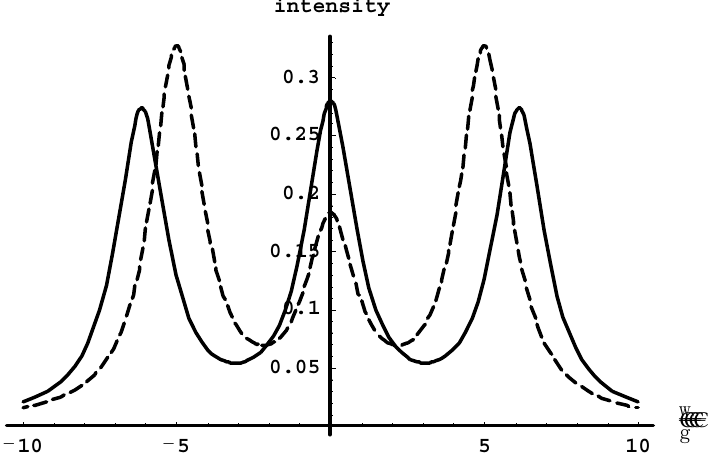
Figure 17. Comparison of the theoretical spectra of the Ly α line for the above example of tokamak T-10 with the allowance for the spiraling trajectories of the perturbing electrons (solid line) and without this allowance (dotted line). The spectra were calculated for the observation at the angle of 45 degrees with respect to the magnetic field. For making the spectra universal, the frequency detuning ω was scaled to the characteristic frequency γ of some of the nonlinear processes in the plasmas (details in [98]).